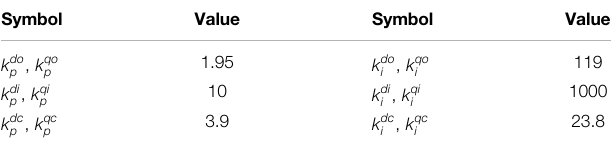
TABLE 4 | The control